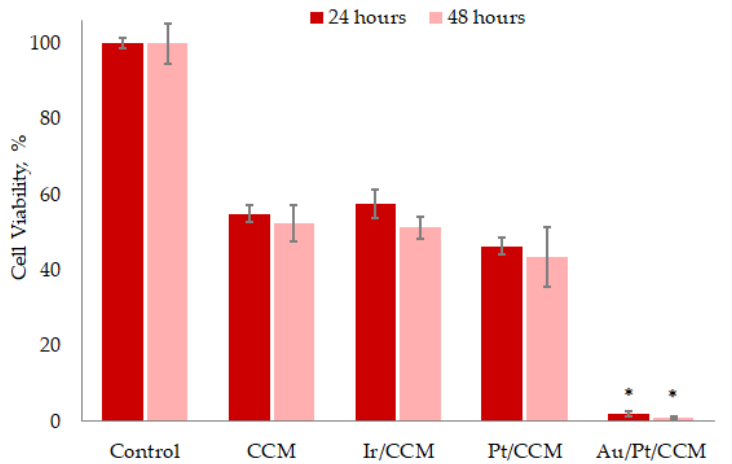
Figure 9. L-929 cell viability after 24 and 48 h of cultivation with extracts of pristine and CCM sam- ples coated with different noble metals. * p < 0.001 (compared to the pristine CCM group). coated with different noble metals. * p < 0.001 (compared to the pristine CCM